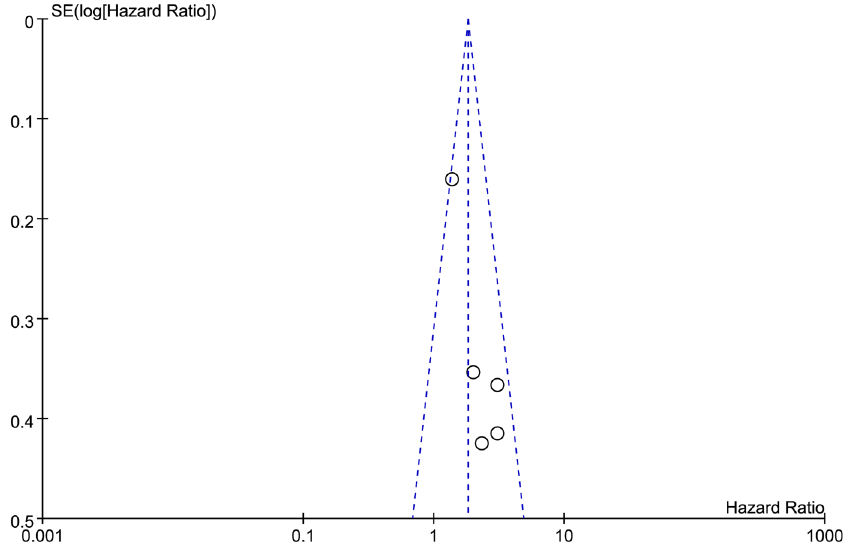
Fig 3. Funnel plot was used to visualize a potential publication bias on overall survival